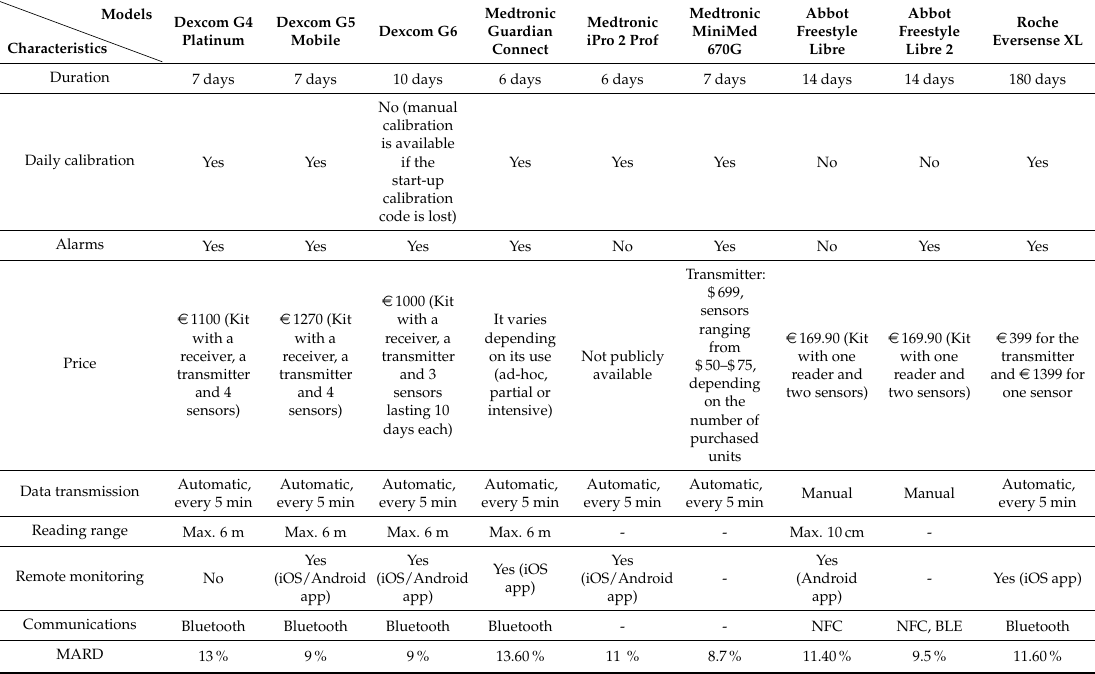
Table 1. Comparison of the characteristics of the most popular